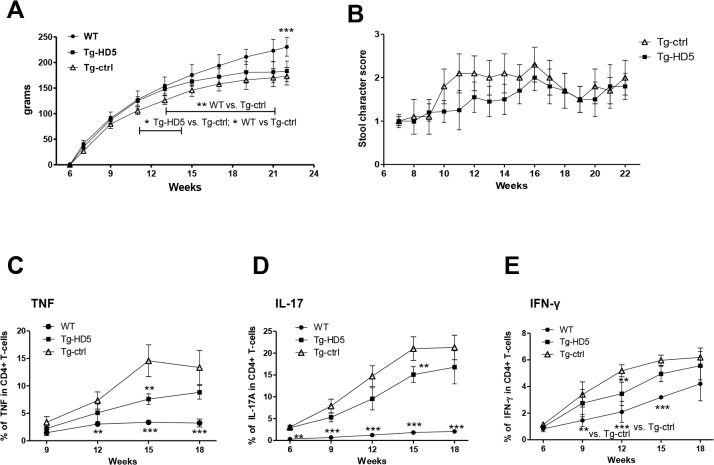
Increased body weight and decreased expansion of pro-inflammatory CD4+ T-cells from blood in Tg-HD5 rats.
(A) Body weight gain from the 6th week of age where the first antibody injections were performed. (B) Stool score from Tg-HD5 and Tg-ctrl groups. (C-E)
In vitro stimulated cells obtained at different time points from the blood of Tg-HD5, Tg-ctrl and WT-littermates were assessed by ICS for the presence of pro-inflammatory cells expressing TNF (C), IL-17 (D) and IFN-γ (E). Results are expressed as percentages of CD4+ T gated cells. Values are expressed as mean±SEM. *p<0.05, **p<0.01, ***p<0.005 as determined by one-way ANOVA followed by Bonferroni post-hoc analysis.